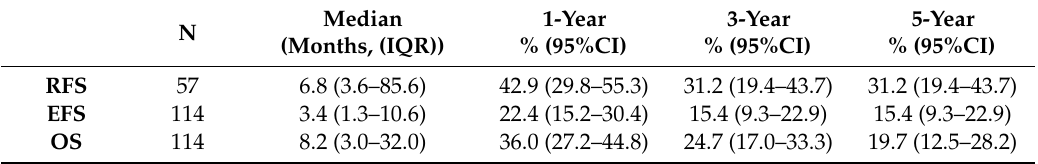
Table 4. Survival of relapsed / refractory FLT3-mutated AML after salvage